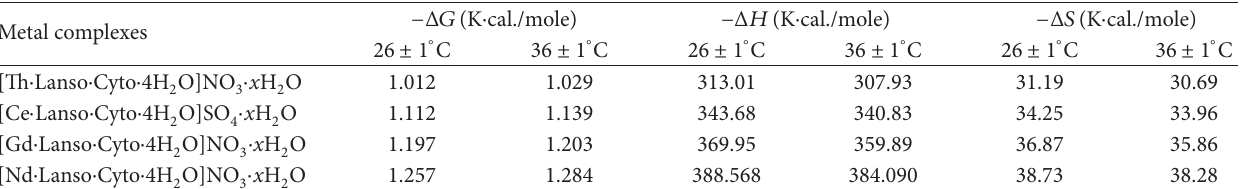
T 2: Ligation free energy, enthalpy, and entropy change of mixed ligand complexes of M-Lanso-Cyto at